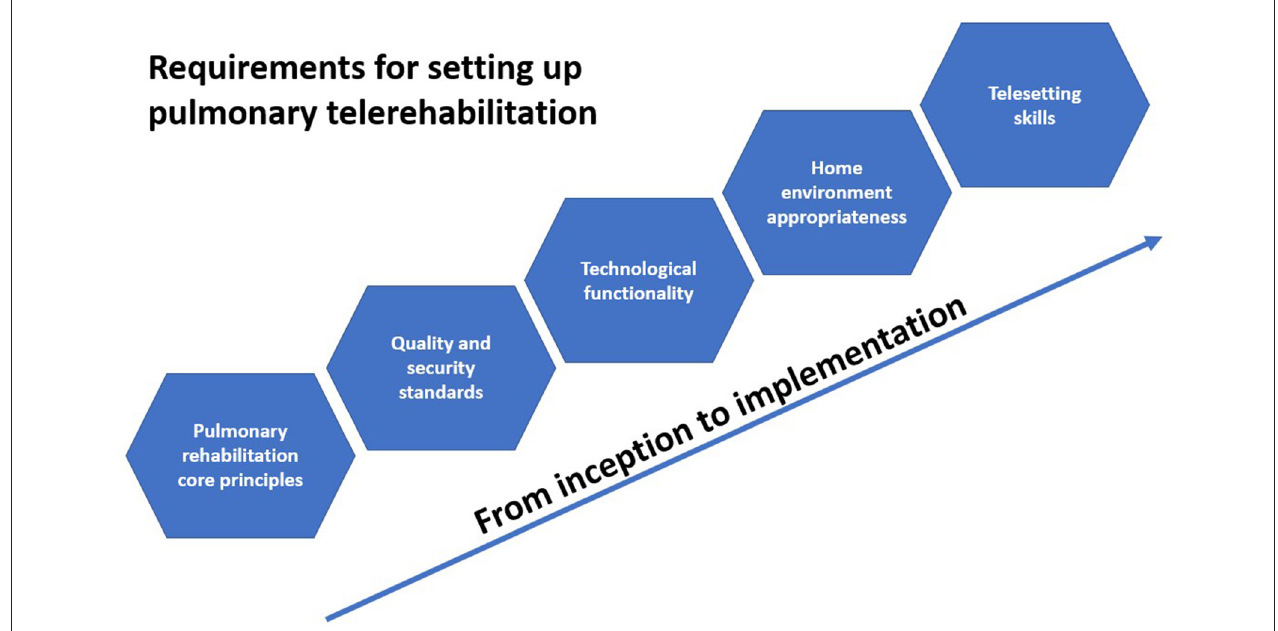
FIGURE 2 | Requirements for setting up pulmonary